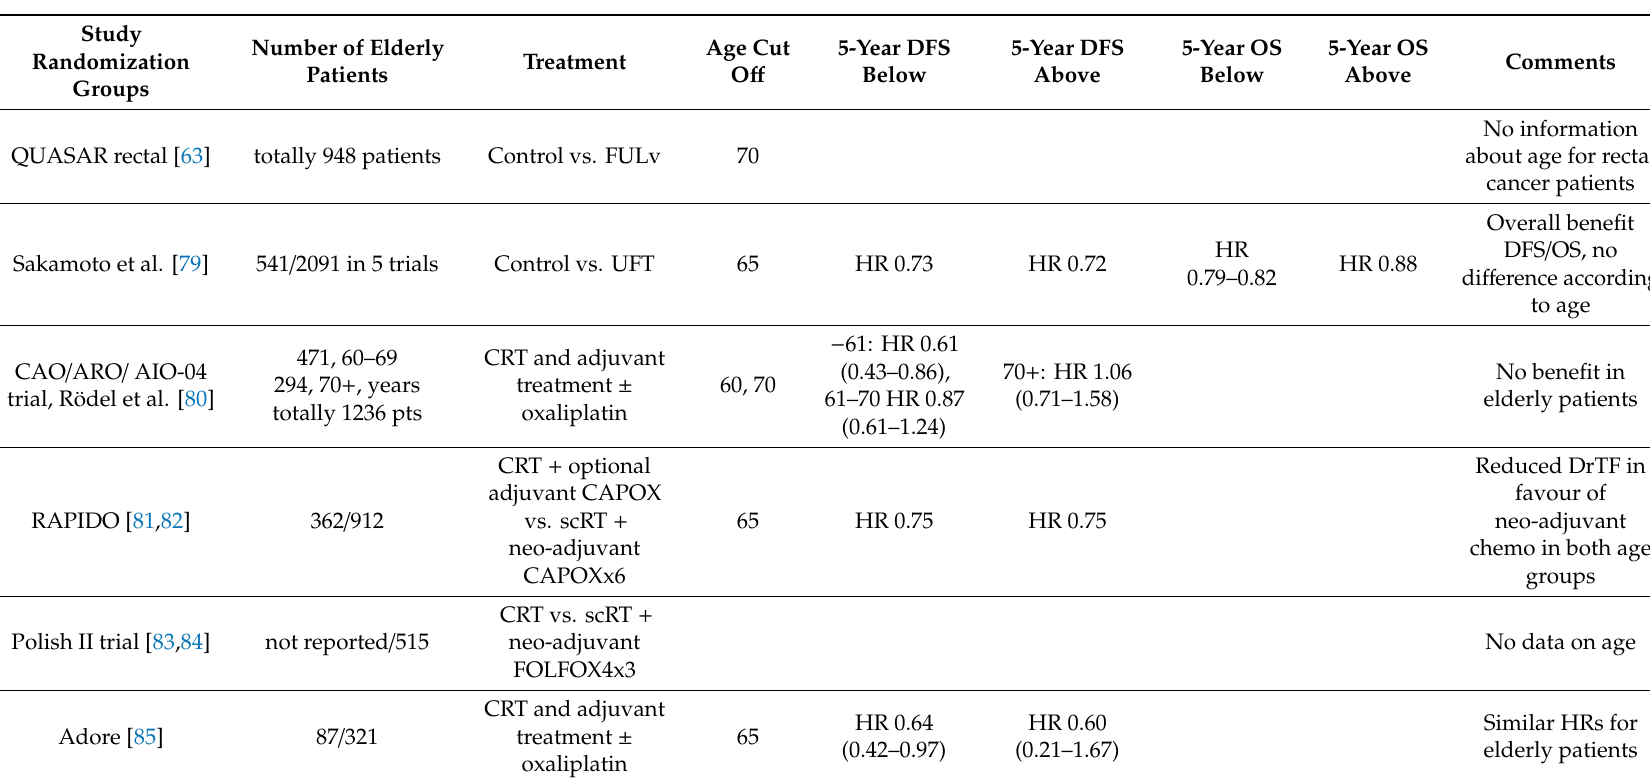
Table 3. Retrospective analyses of the importance of age for the benefit of adjuvant / neo-adjuvant chemotherapy in randomized trials in patients with rectal